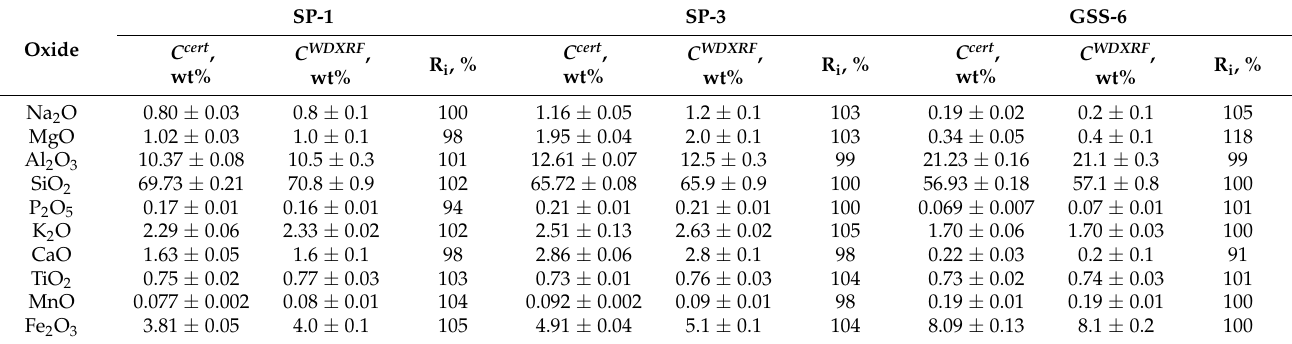
Table 4. The WDXRF results validation with the CRMs of soils.